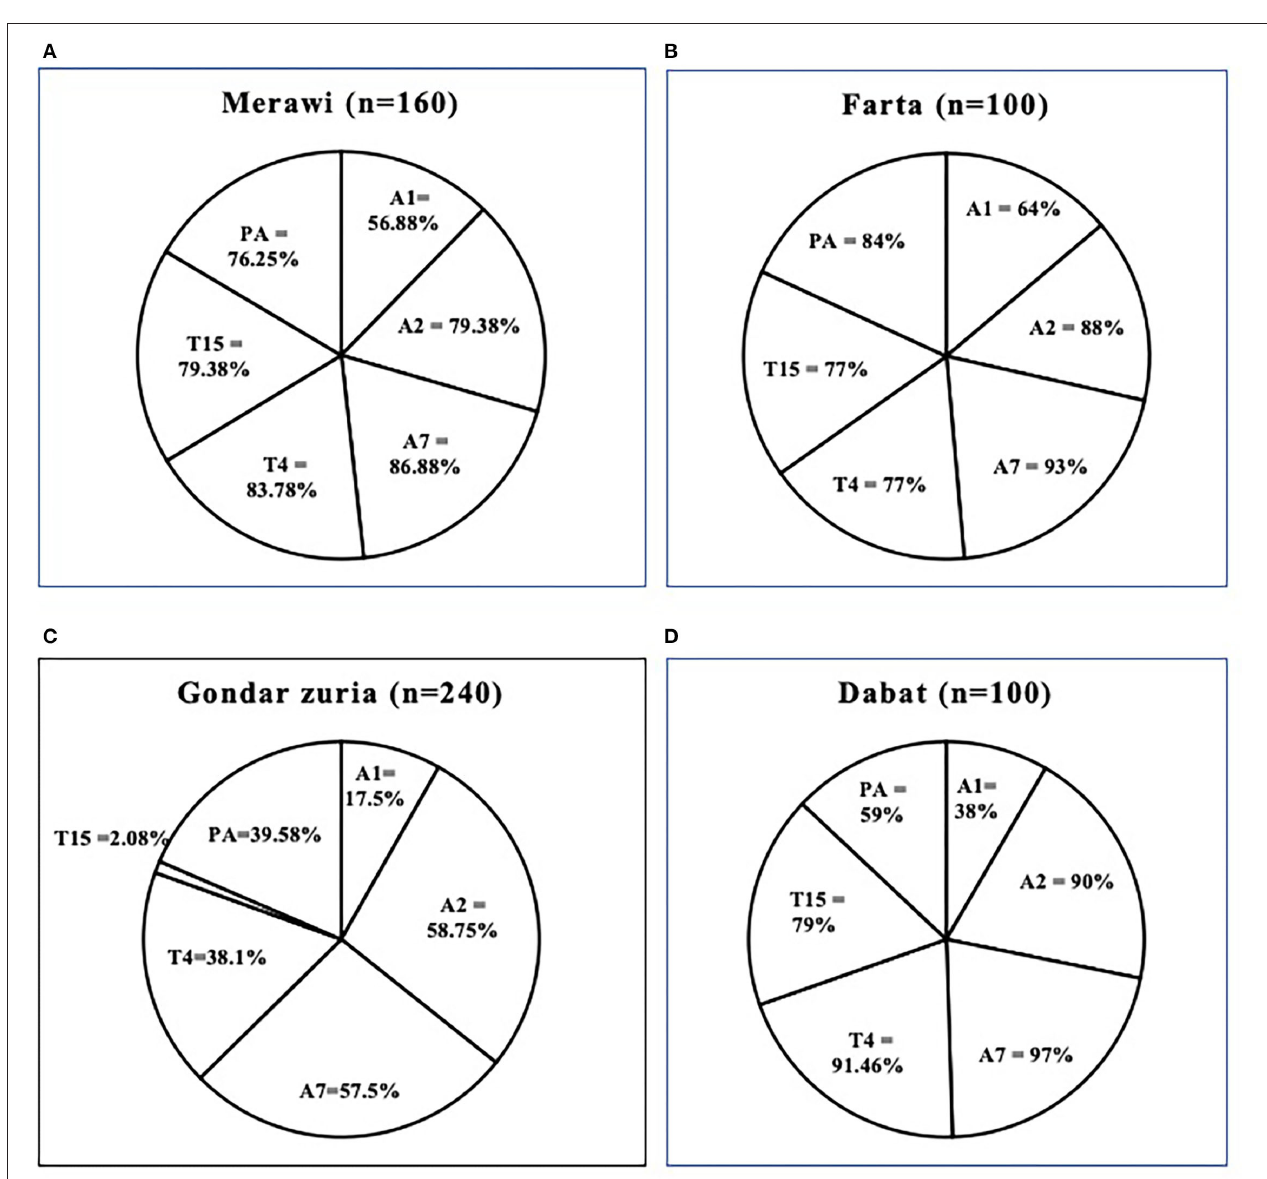
FIGURE 4 | Prevalence and percentage of various serotypes of M. haemolytica , P. multocida , and B. trehalosi for each district: Merawi (A) , Farta (B) , Gondar Zuria (C) , and Dabat (D) . All the districts have been shown to have a high prevalence of the six (6) serotypes except for the Gondar Zuria district where T15 had an unusually low prevalence as compared to the other districts. Infection with multiple serotypes is apparent in all the sampled animals. PA = P. multocida biotype A .